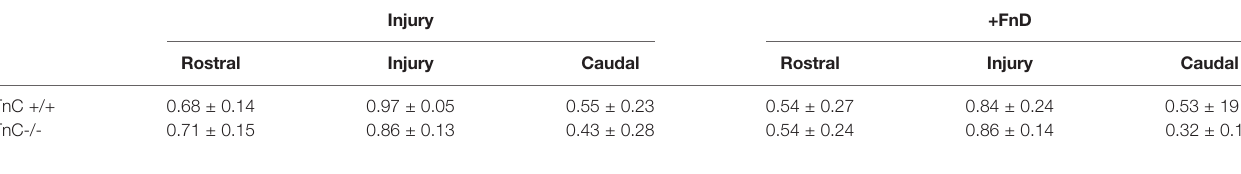
TABLE 8 | Mean values ± standard deviations of the portion of activated microglia numbers in the injured spinal cord of TnC +/+ and TnC − / − mice.